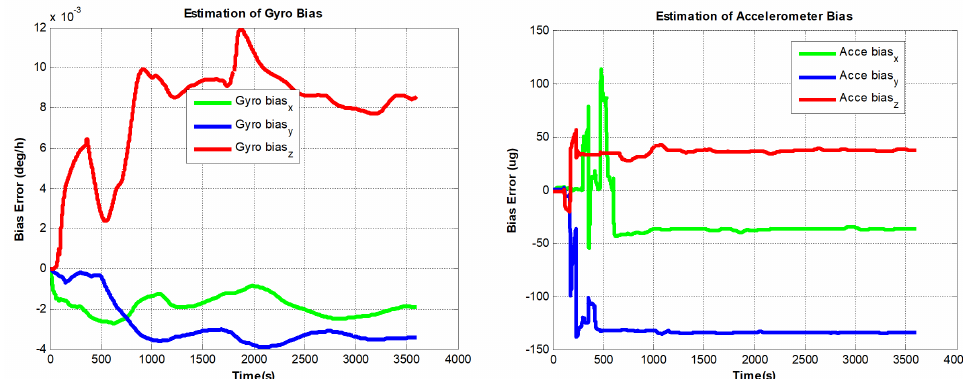
Figure 7. PIGA-based IMU biases estimation curves.